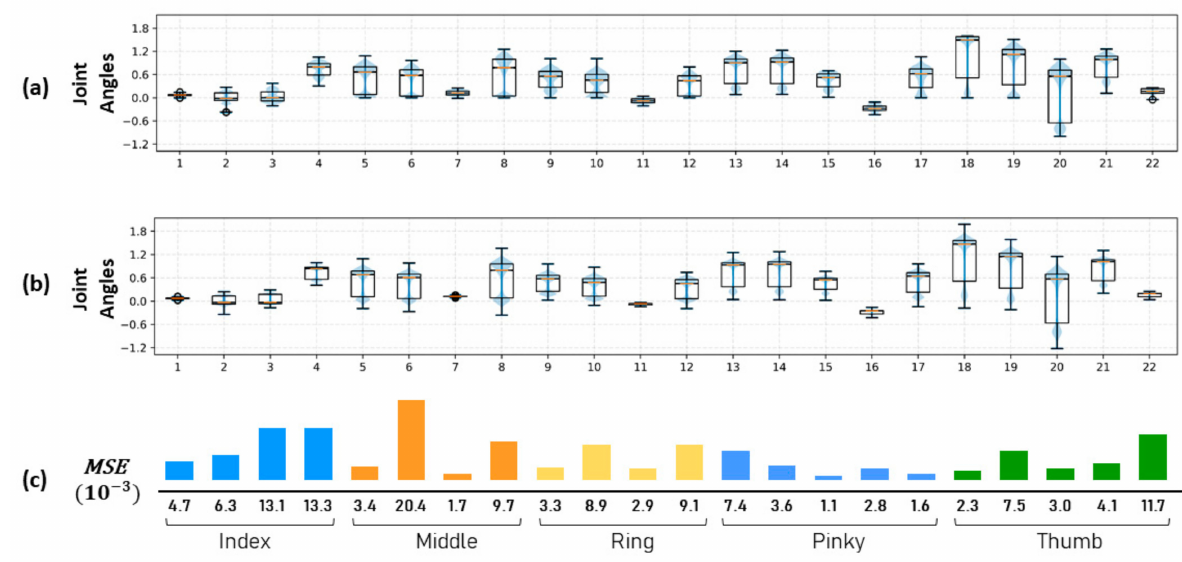
Figure 4. The mean squared error ( c ) between the joint angle distributions of the haptic map dataset, ( a ) and the angles distributions estimated by the regressor ( b ) for each finger in the anthropomorphic hand. A lower error indicates higher confidence in estimating the joint angles of a natural grasping